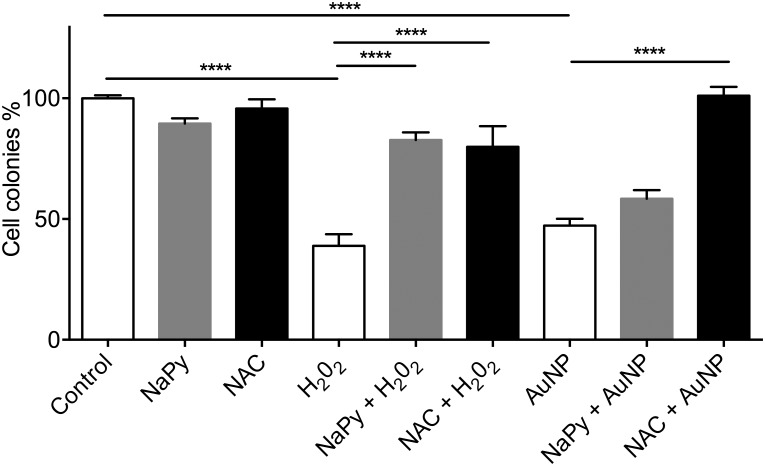
Clonogenic assay of HSC-3 cells exposed to 1 μg/ml 50:50 αGal:PEG-amine AuNPs in presence or in absence of 0.1 mM sodium pyruvate (NaPy) or 1 mM N-acetylcysteine (NAC) antioxidants.For each condition, n = 3 and data are presented ±SEM. **** Denotes a significant difference (P<0.0001 ANOVA, Tukey multiple comparisons post-test).